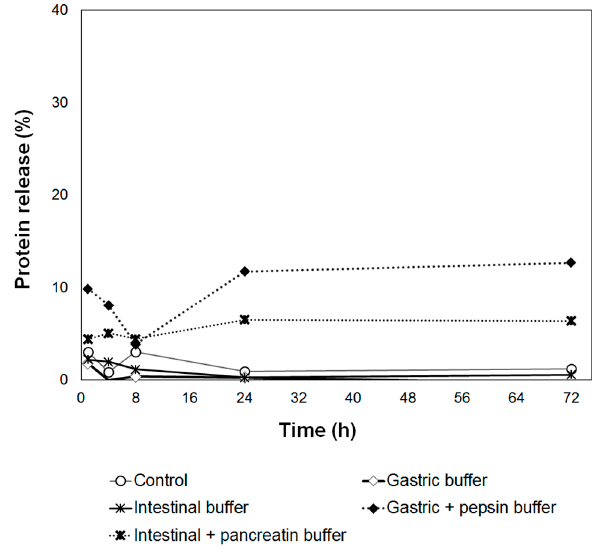
Figure 12. Cumulative release of BSA over 72 h in different mediums and the control sample.